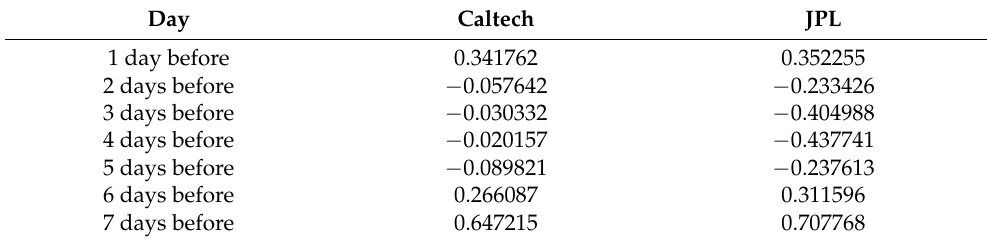
Table 4. Correlation score of historical power delivered.